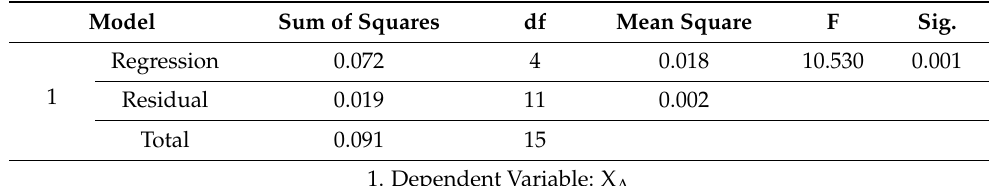
Table 16. ANOVA for 2nd order polynomial with two